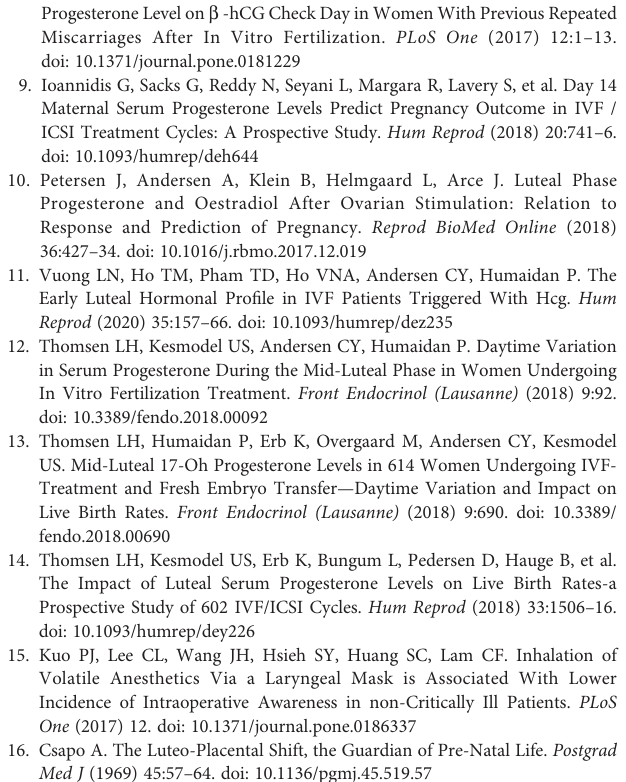
Supplementary Figure 1 | Linear regression model of serum P levels throughout the late luteal phase, comparing ongoing pregnancies (green) and negative b -hCG cases (orange) differentiating cycles with own or donated